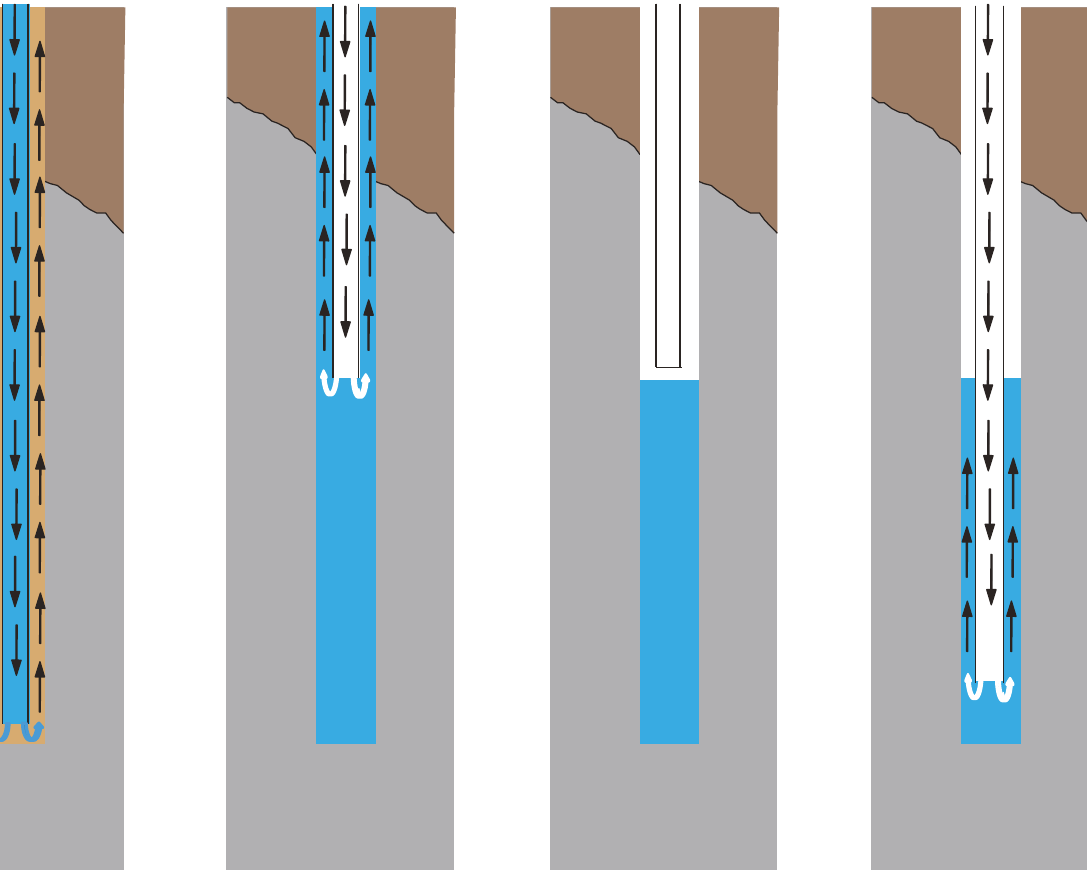
Figure 3: Schematic diagram showing (from left to right) replacement of drilling mud by water after each coring run, and the water in the borehole is then progressively fl ushed out from top to bottom of the pilot borehole KFD1 in ~ 100 m